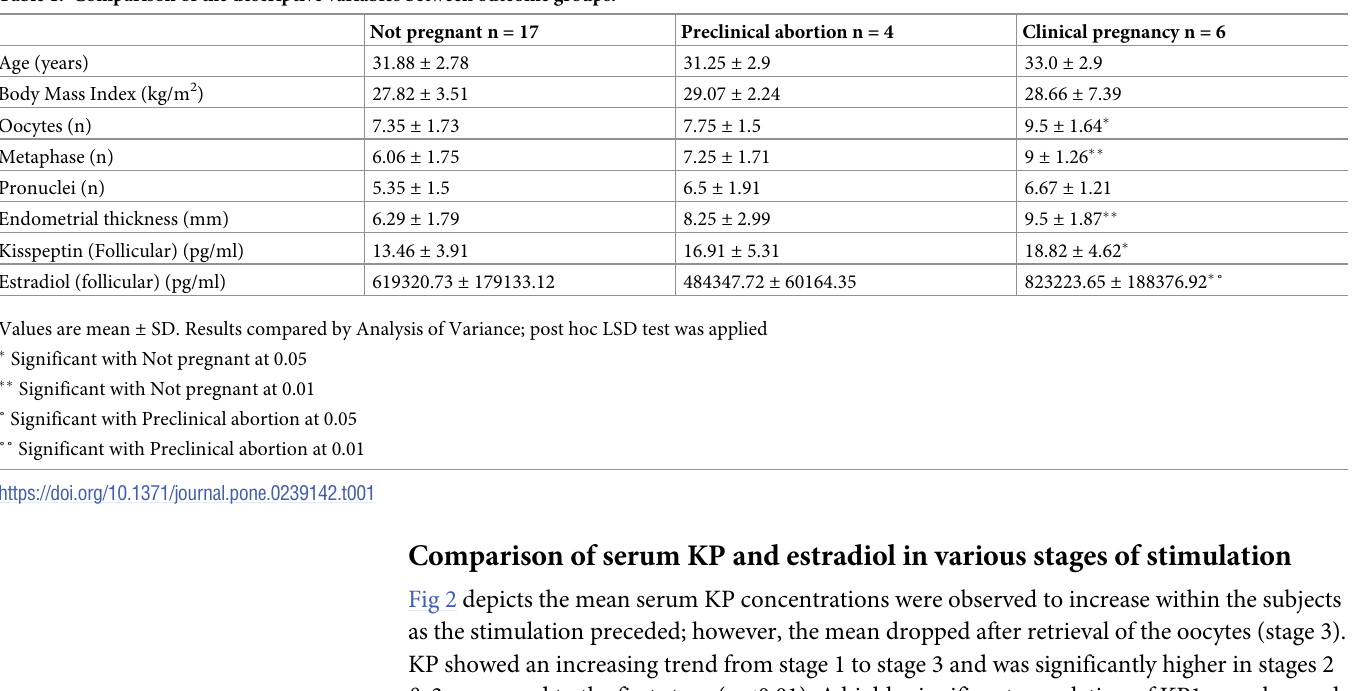
Table 1. Comparison of the descriptive variables between outcome